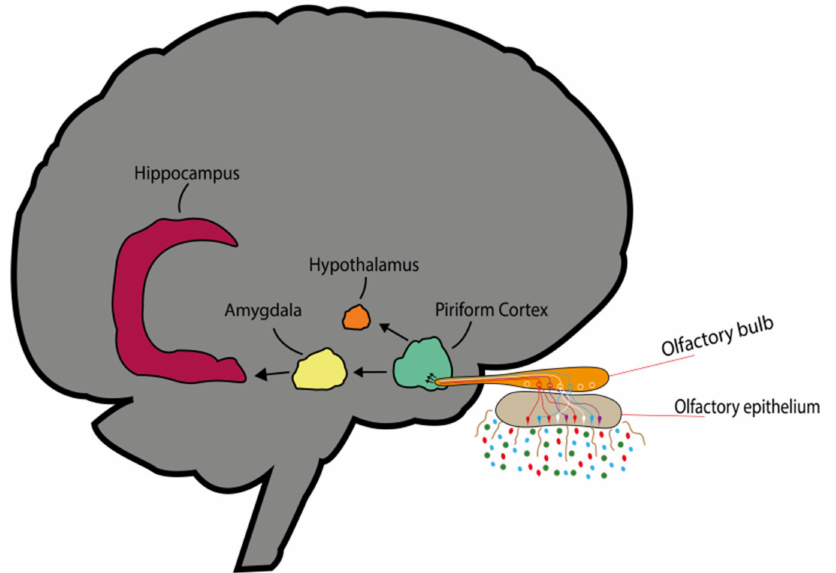
Figure 2. Inhaled odour molecule activating unique OSN receptors. The axon of the OSN converges to its corresponding glomerulus and each glomerulus input to its associated mitral and tufted cells. The odorant signal is further transmitted into the olfactory cortex where it stimulates the corresponding regions of the limbic